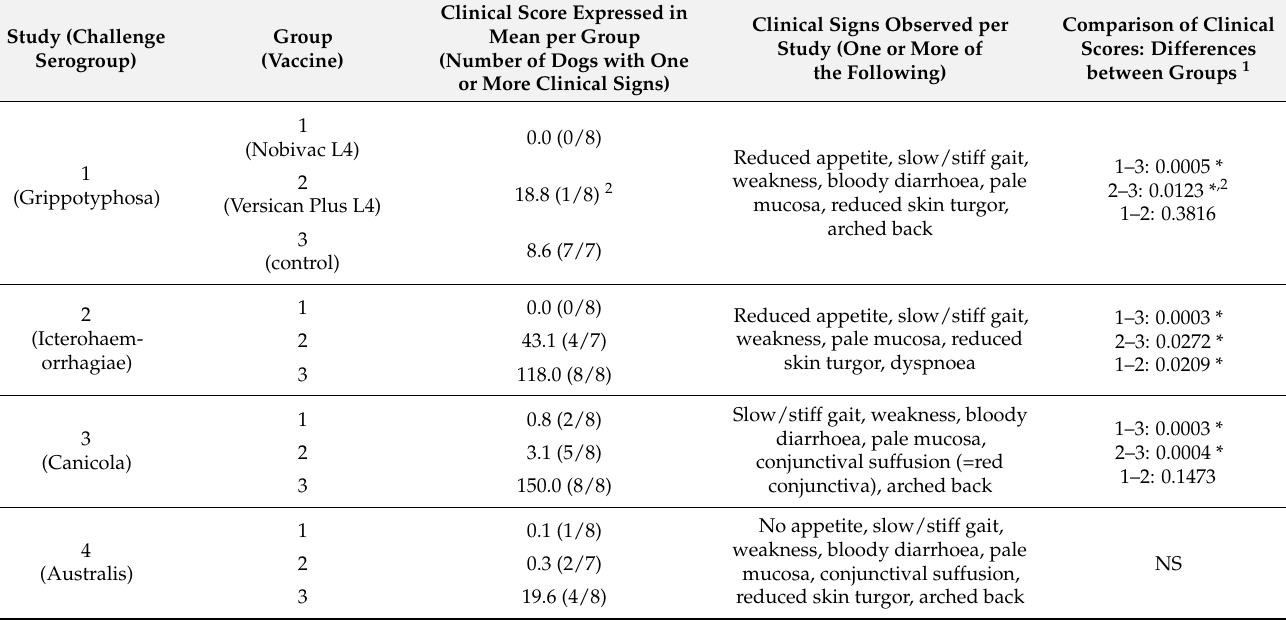
Figure 2. Body temperature after challenge in studies 1–4. The asterisks indicate a significant difference ( p < 0.05) as follows: ( A ) day post-challenge (dpc) 2: group 1 versus 3: p = 0.0054; group 2 versus 3: p = 0.0088; dpc 5: group 1 versus 3: p = 0.0235; group 2 versus 3: p = 0.0481. ( B ) dpc 2: group 1 versus 3: p = 0.0395; group 2 versus 3: p = 0.0321; dpc 3: group 1 versus 3: p = 0.0176; group 2 versus 3: p = 0.0320. ( C ) dpc 3: group 1 versus 3: p = 0.0202; group 2 versus 3: p = 0.0009. ( D ) No statistically significant differences between groups. Table 2. Scores of laboratory-confirmed clinical signs of leptospirosis in studies